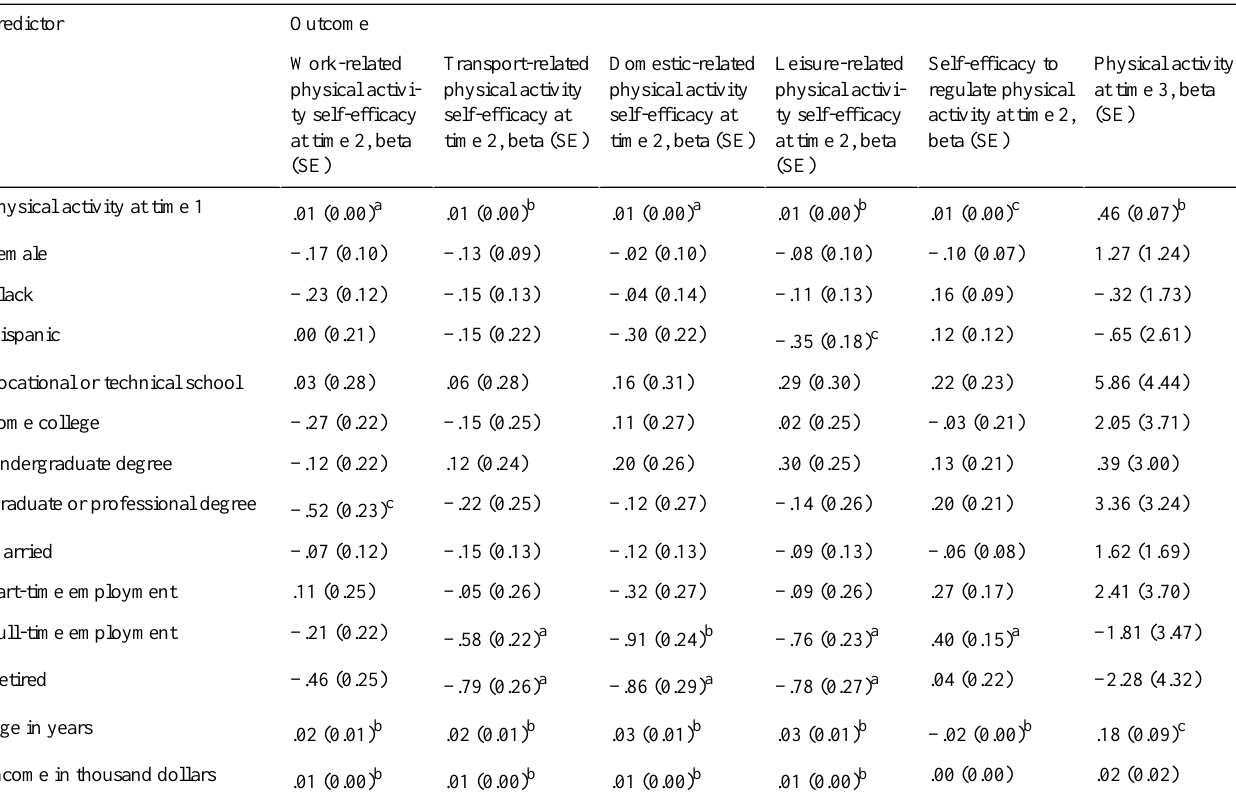
Table 2. Unstandardized estimate of the covariates from the path